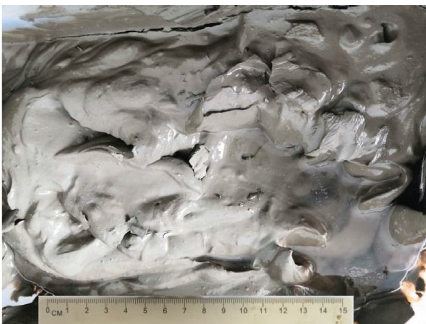
Figure 1: Slurry after preliminary dehydration treatment.